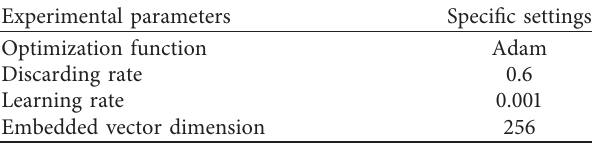
Table 1: Experimental training